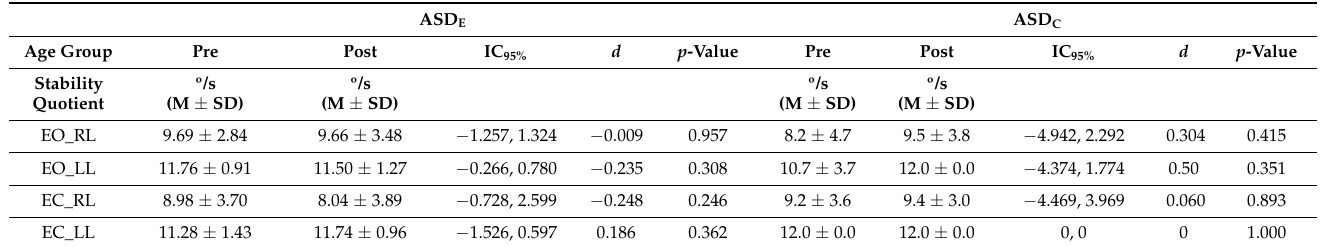
Table 4. Descriptive values (M ± SD) for the conditions of eyes opened and closed. ASD E ASD